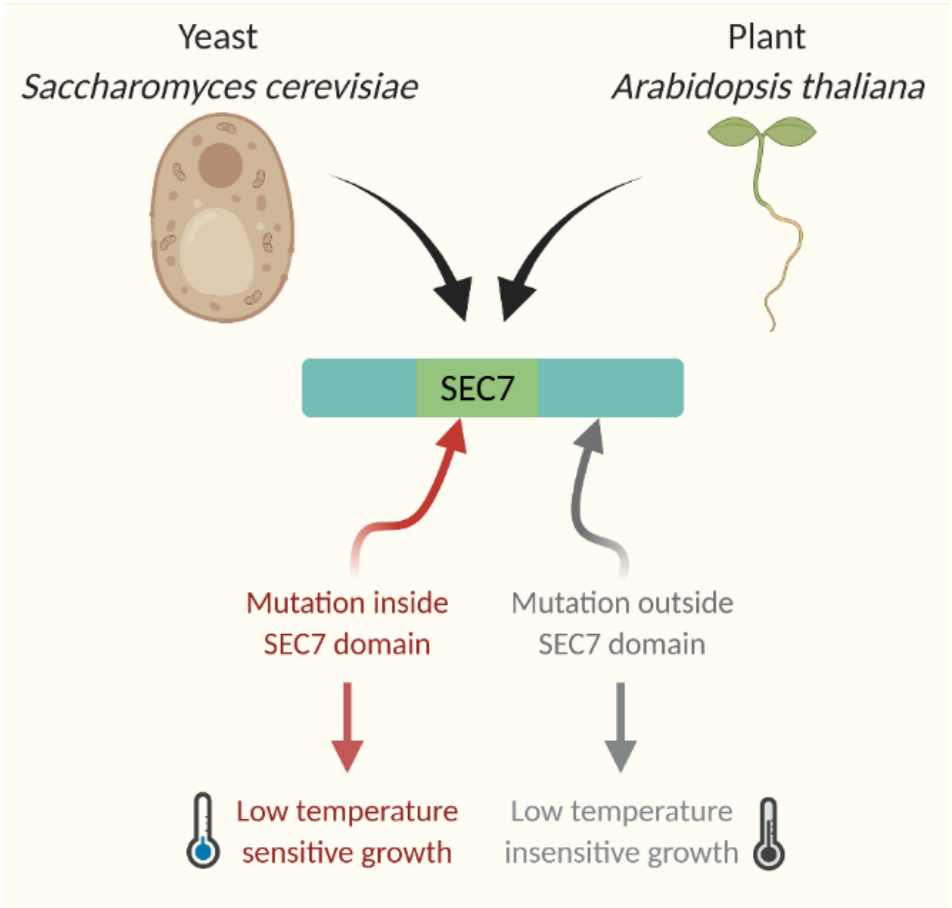
Figure 4. Role of SEC7 domain in temperature response. SEC7 domain-containing proteins are responding to low temperature in both Saccharomyces cerevisiae and Arabidopsis thaliana .